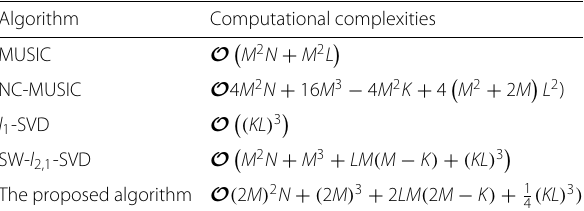
Table 1 Computational complexity Algorithm Computational